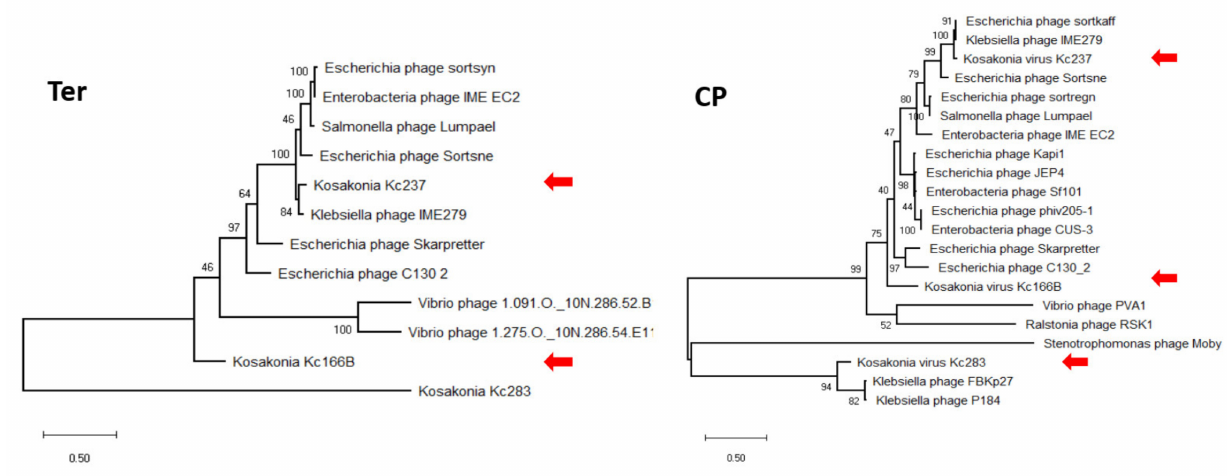
Figure 6. Maximum-likelihood phylogenetic tree computed on mCP ( a ) and terminase ( b ) aa